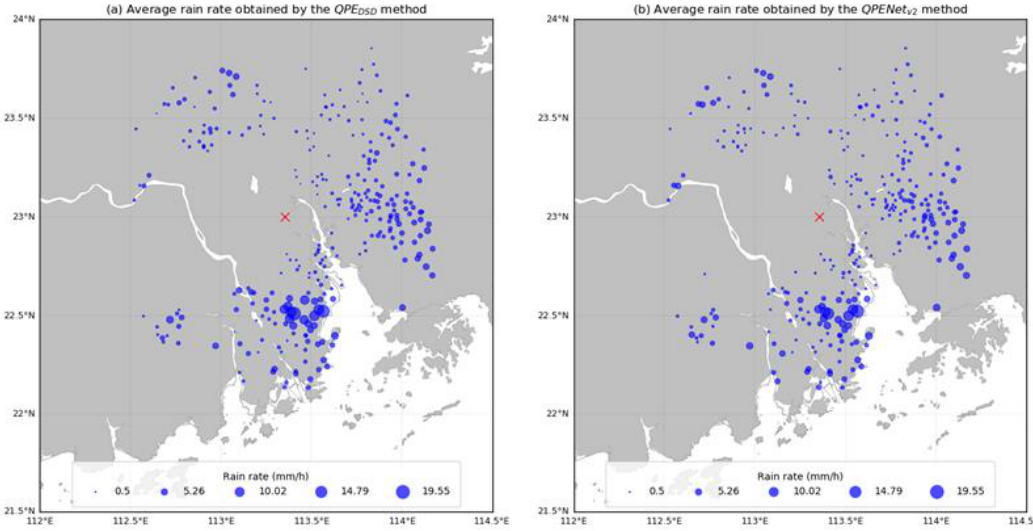
Figure 6. Hourly rainfall estimates using ( a ) QPE DSD and ( b ) QPENet v2 during typhoon Merbok. The red cross represents the location of the Guangzhou radar.